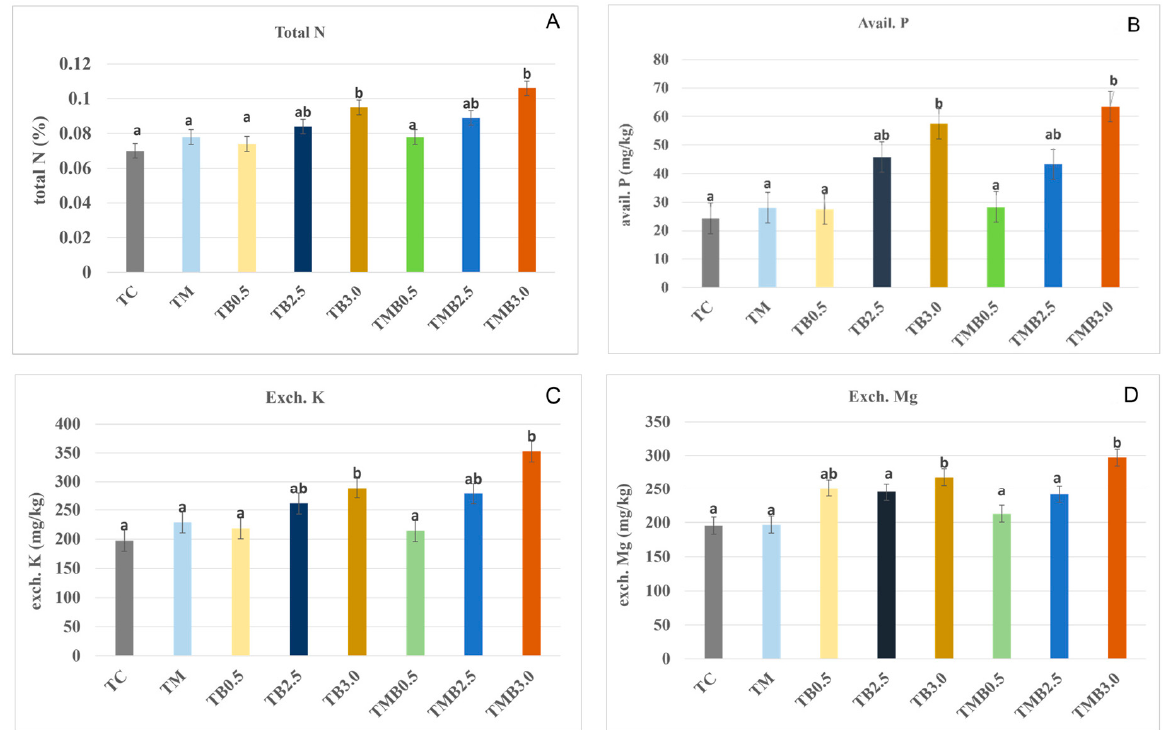
Figure 2. The total nitrogen ( A ), available phosphorous ( B ), exchangeable potassium ( C ), and exchangeable magnesium ( D ) in the soil in different experimental plots after maize cultivation. Remark: Data shown as the mean ± SE with harmonic mean sample size = 4.000. The different letters represent a statistically significant difference in the data at p <